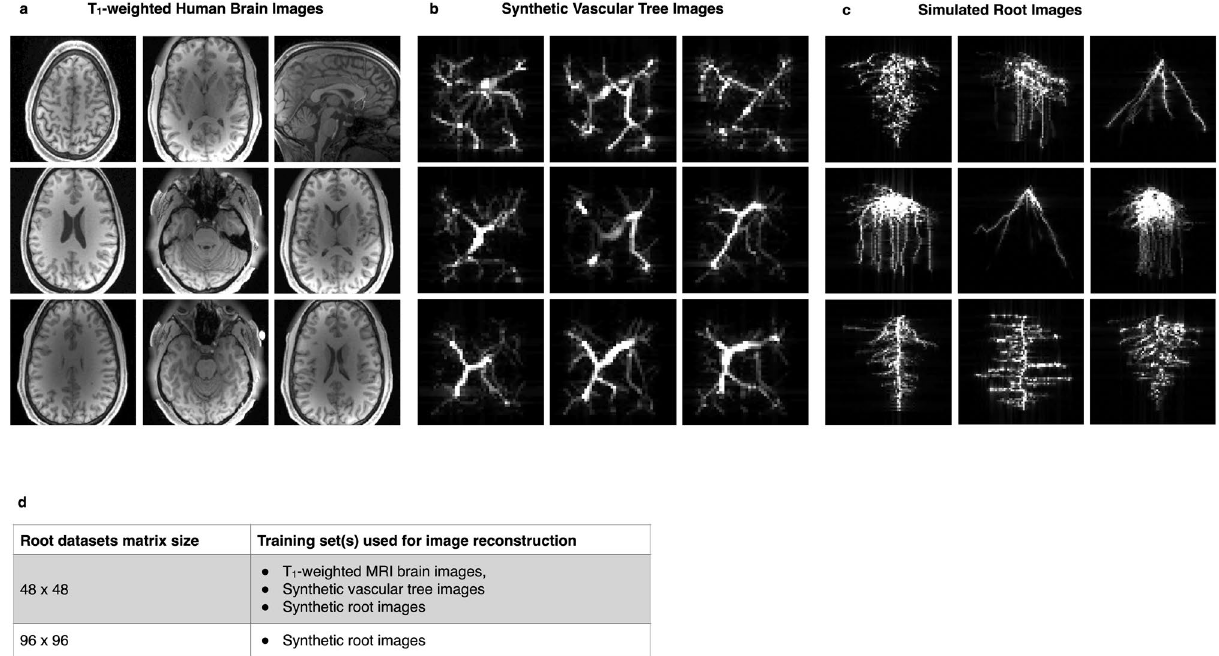
Figure 6. Domain-specific training corpora used on plant roots dataset—( a – c ) Representative images from three training sets for root MRI reconstruction. ( a ) 2D images from the Human Connectome Project database. ( b ) 2D images from the training set based on synthetic vascular trees. Each of the 2D images was obtained by summing up the 3D synthetic vascular tree volumes in all 3 dimensions. ( c ) Images of realistic simulated root system from the RootBox toolbox. ( d ) The list of matrix sizes of the acquired root datasets and their corresponding training set used for image